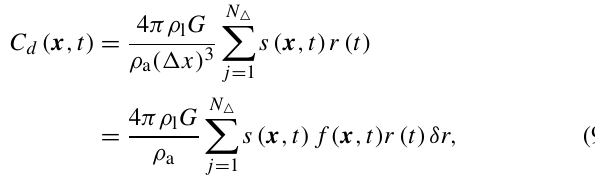
Table 1. List of constants for the thermodynamics: see text for ex- planations of